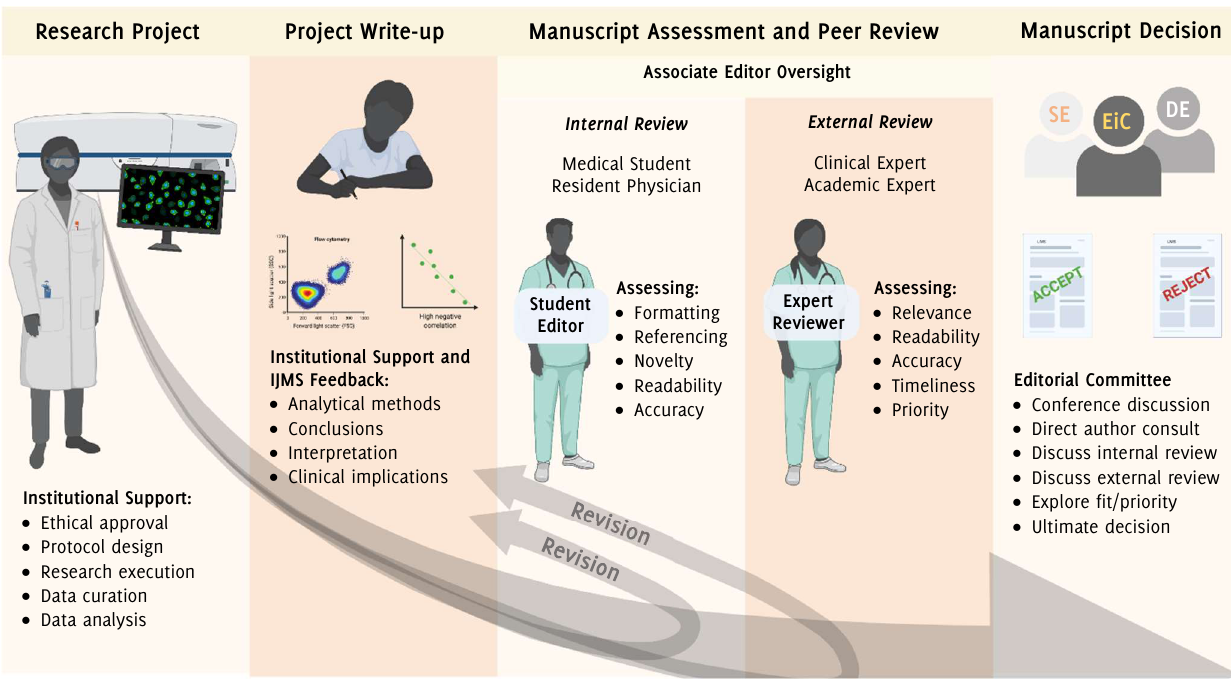
Legend: The additional layer of internal review which Student Editors provide is key to the success of the Journal. This allows for essential feedback early on in the process which may ultimately bring a manuscript up to the level required for traditional external peer review. SE, Scientific Editor; EiC, Editor in Chief; DE, Deputy